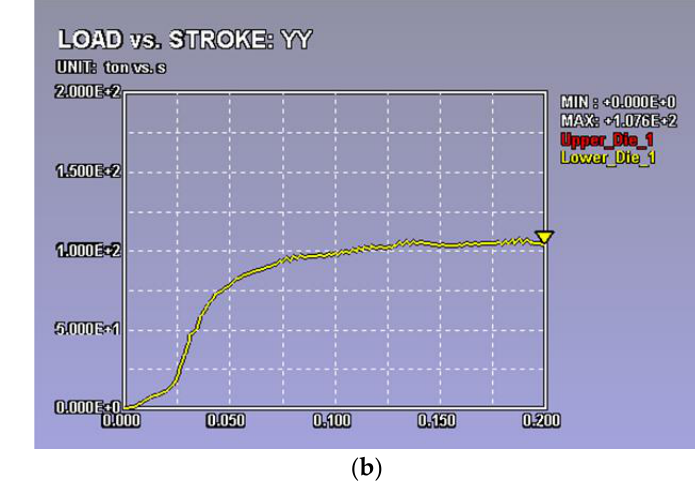
Figure 2. ( a ) FE Simulation; ( b ) load versus stroke curve to capture maximum punch force.